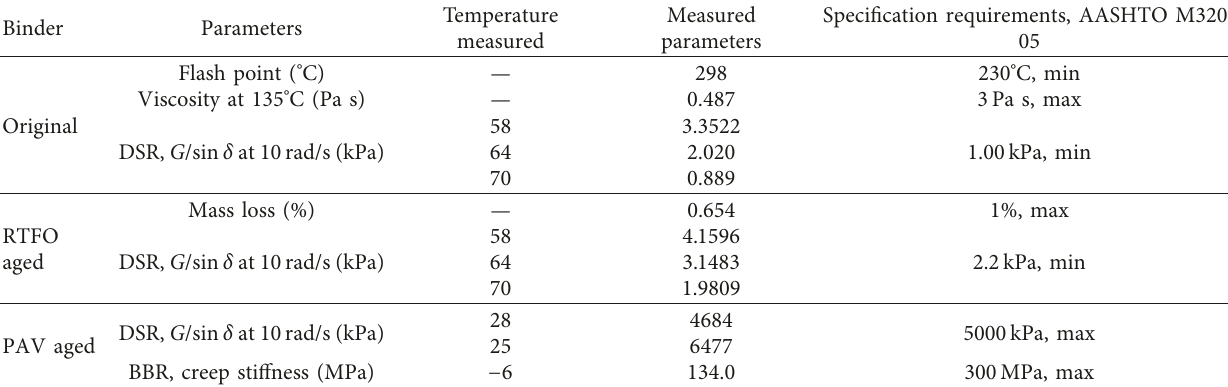
Table 1: Physical properties of asphalt cement based on performance